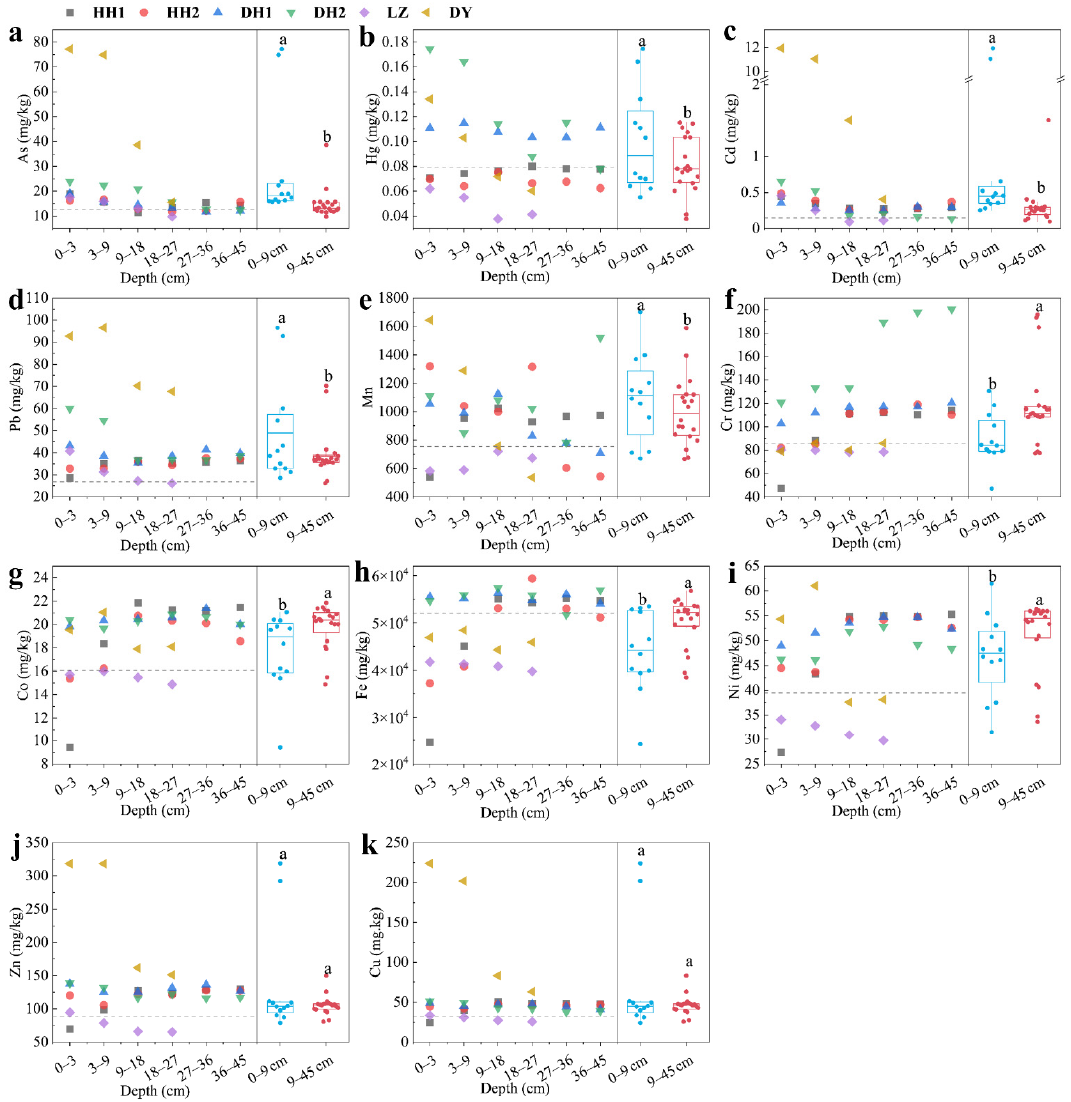
Figure 3. Concentration of target heavy metals in sediment cores (dry weight). Different letters (a or b) represent statistically significant differences at the p < 0.05 level. The gray dotted line is the environmental background value.